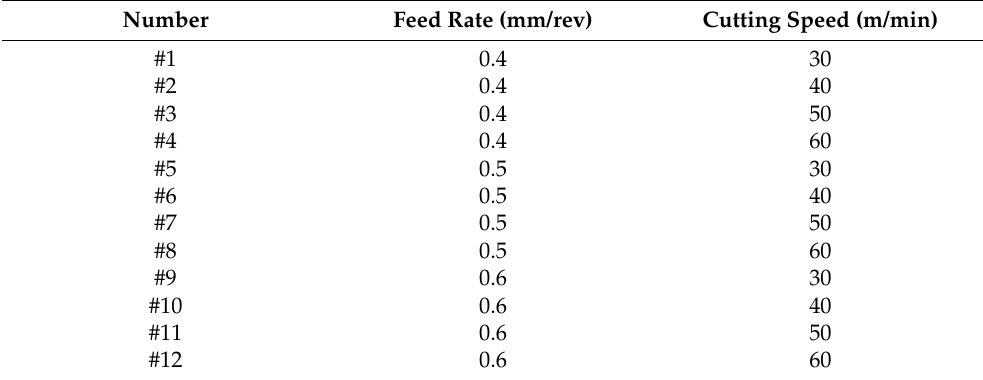
Table 3. The machining parameters were selected according to the references [17–19] and the actual production machining experience of the factory. Table 3. Full factor experimental design: the machining parameters of Tool A (#1~#12) and Tool B (#1~#12) in reaming